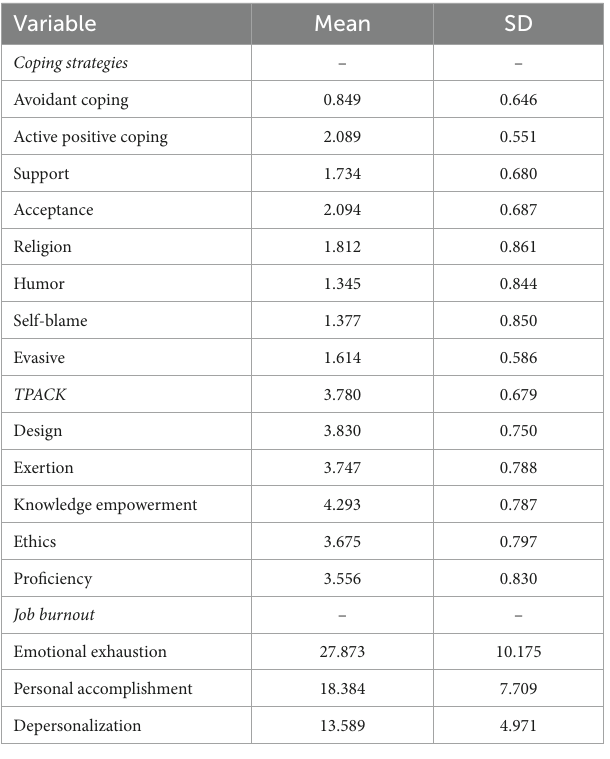
TABLE 2 Descriptive statistics of the variables of the